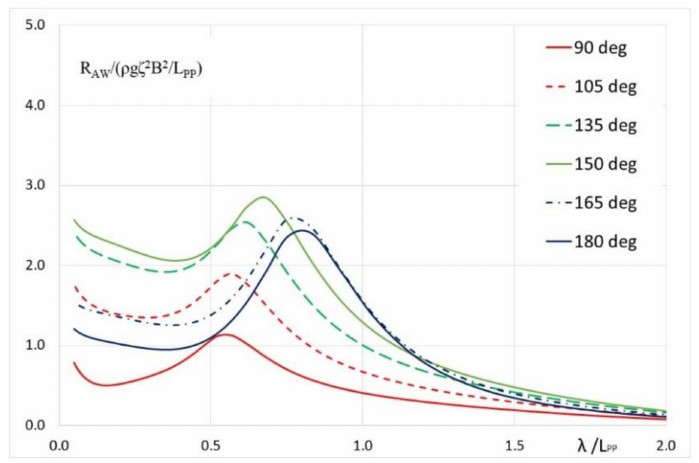
Figure 2. Added resistance of the subject VLCC at 2 knots in regular waves of various directions.